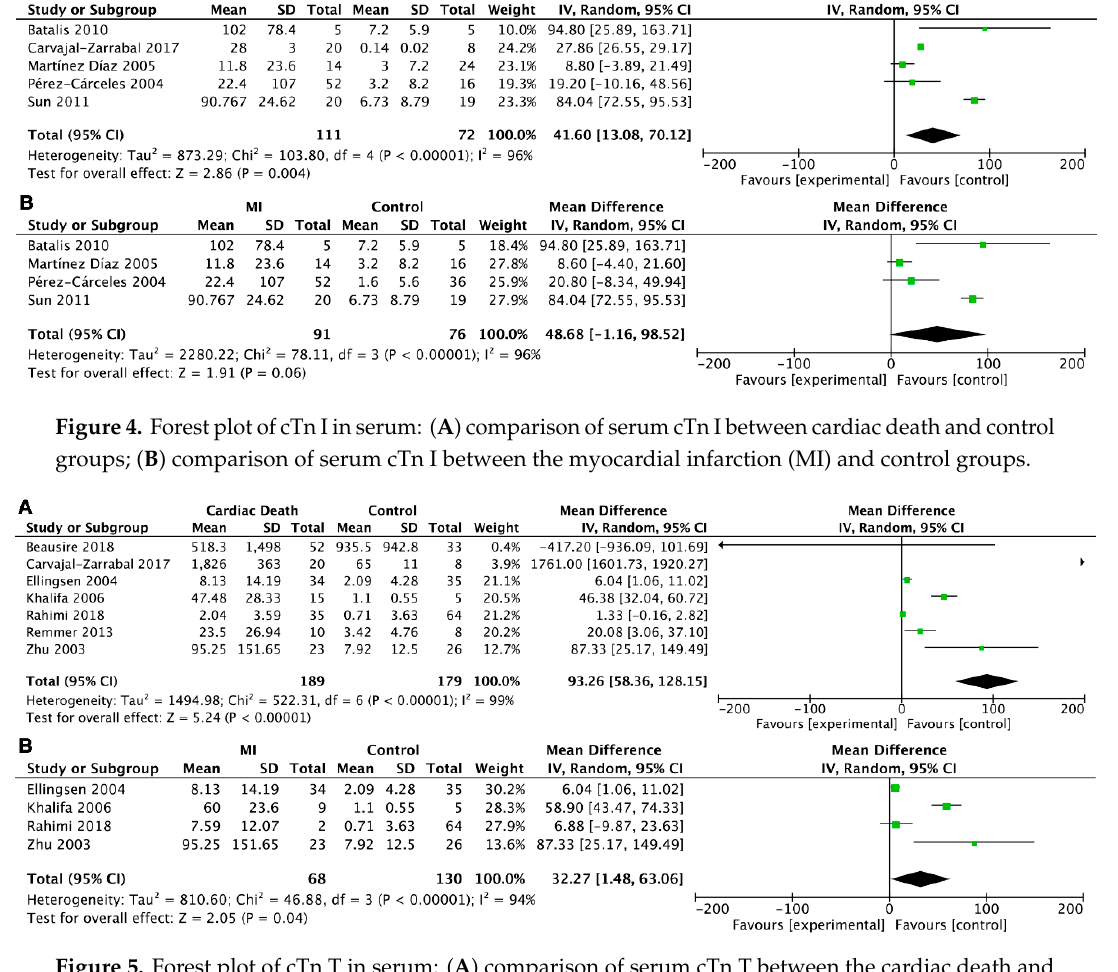
Figure 5. Forest plot of cTn T in serum: ( A ) comparison of serum cTn T between the cardiac death and control groups; ( B ) comparison of serum cTn T between the MI and control groups.